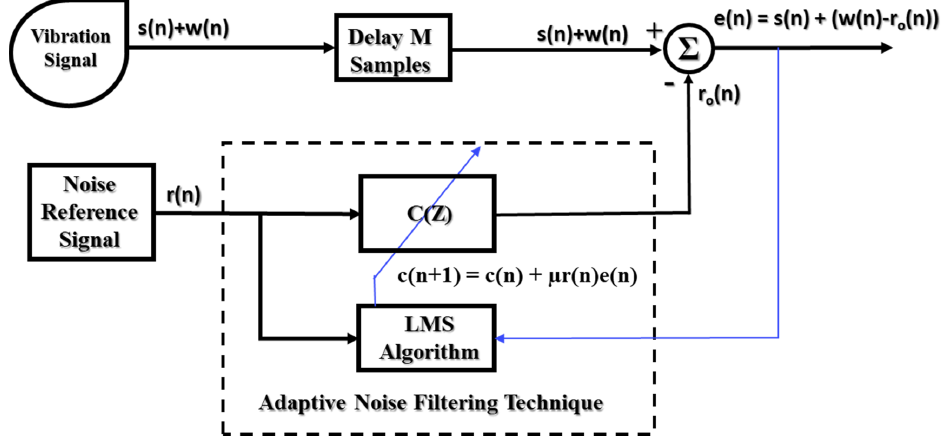
Figure 7. Function block diagram of an adaptive noise filtering technique.